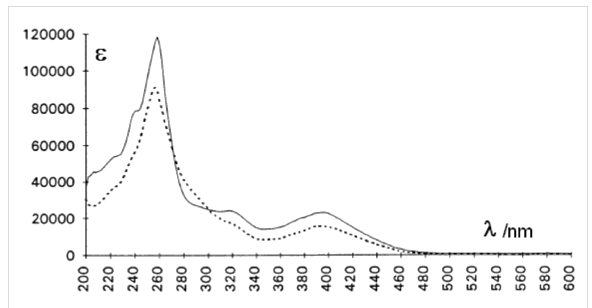
Figure 6: Electronic absorption spectra of 2 (conc. ca 10 −4 M) in MCH (full line) and CH 3 CN (dotted line) at 20